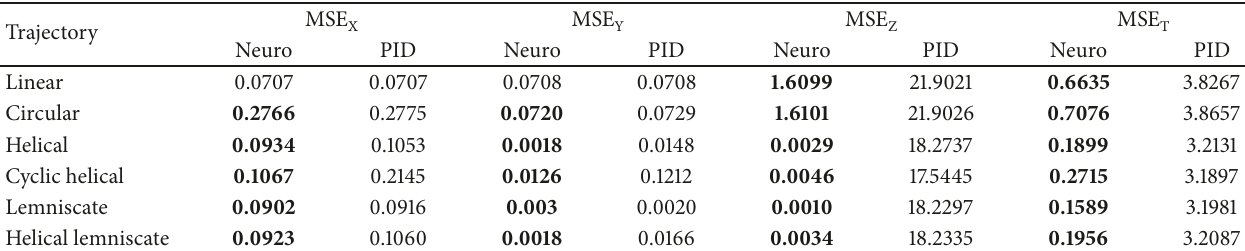
Figure 16: Mass obtained by the neural estimator with a sinusoidal mass change profile. Table 3: Comparison of the MSE of the tracking error for different trajectories with mass